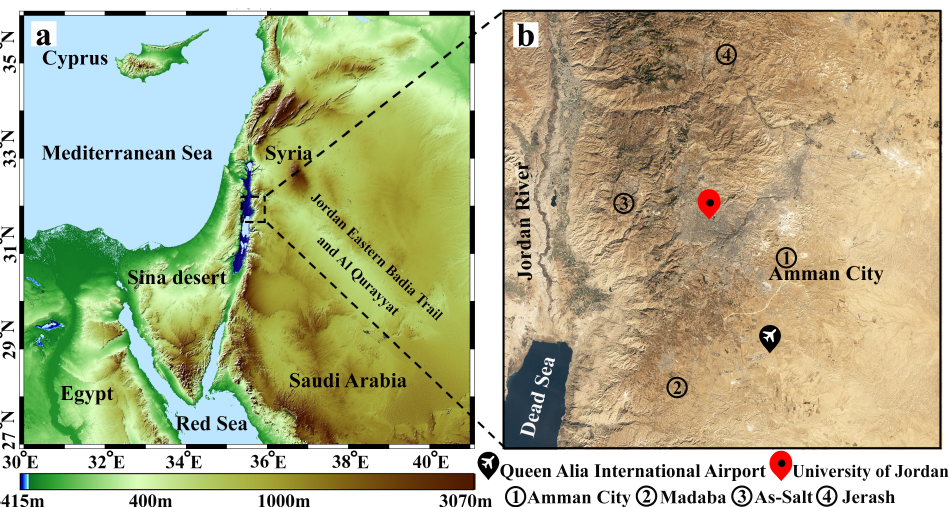
Figure 1. ( a ) Topography of Jordan and neighboring countries provided by Shuttle Radar Topography Mission project (SRTM) and ( b ) Landsat 8 true color image of Amman, ground-based particulate matter station, and some important locations surrounding